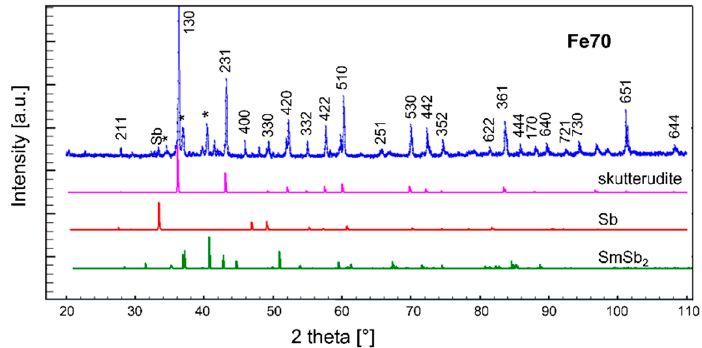
Figure 3. X-ray diffraction pattern of sample Fe70 and calculated diffractograms of skutterudite, Sb and SmSb 2 . In the experimental pattern, Miller indexes of the skutterudite phase are indicated, as well as the position of the main peaks of the additional phases Sb and SmSb 2 (asterisks). Microhardness was measured at several points of both phases on the Fe70 surface; results clearly show a clustering of data around two values, namely 462(23) and 373(14) HV, the former being associated to skutterudite and the latter to the SmSb 2 extra phase.